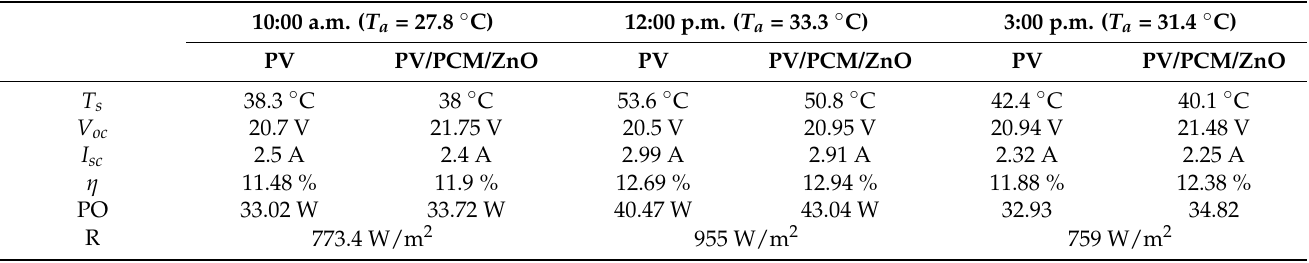
Table 3. Ambient temperature ( T a ), module surface temperature ( T s ), open circuit voltage ( V oc ), short circuit current ( I sc ), and efficiency ( η ) of photovoltaic (PV) and PV integrated with ZnO-doped PCM at 10:00 a.m., 12:00 p.m., and 3:00 p.m. under different solar radiations